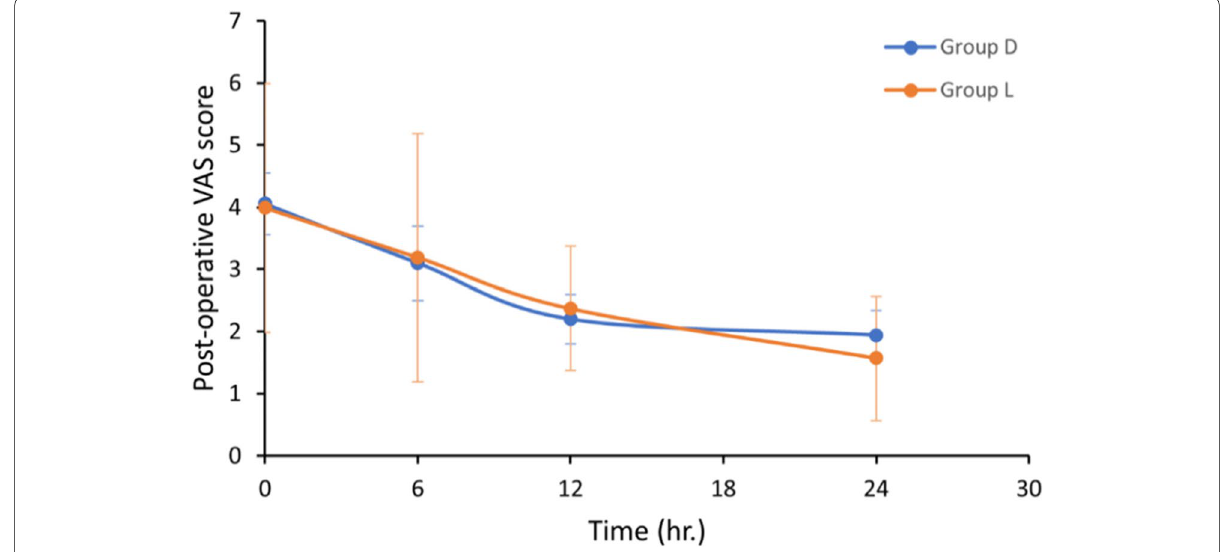
Fig. 5 Comparison of post-operative VAS score for the two groups